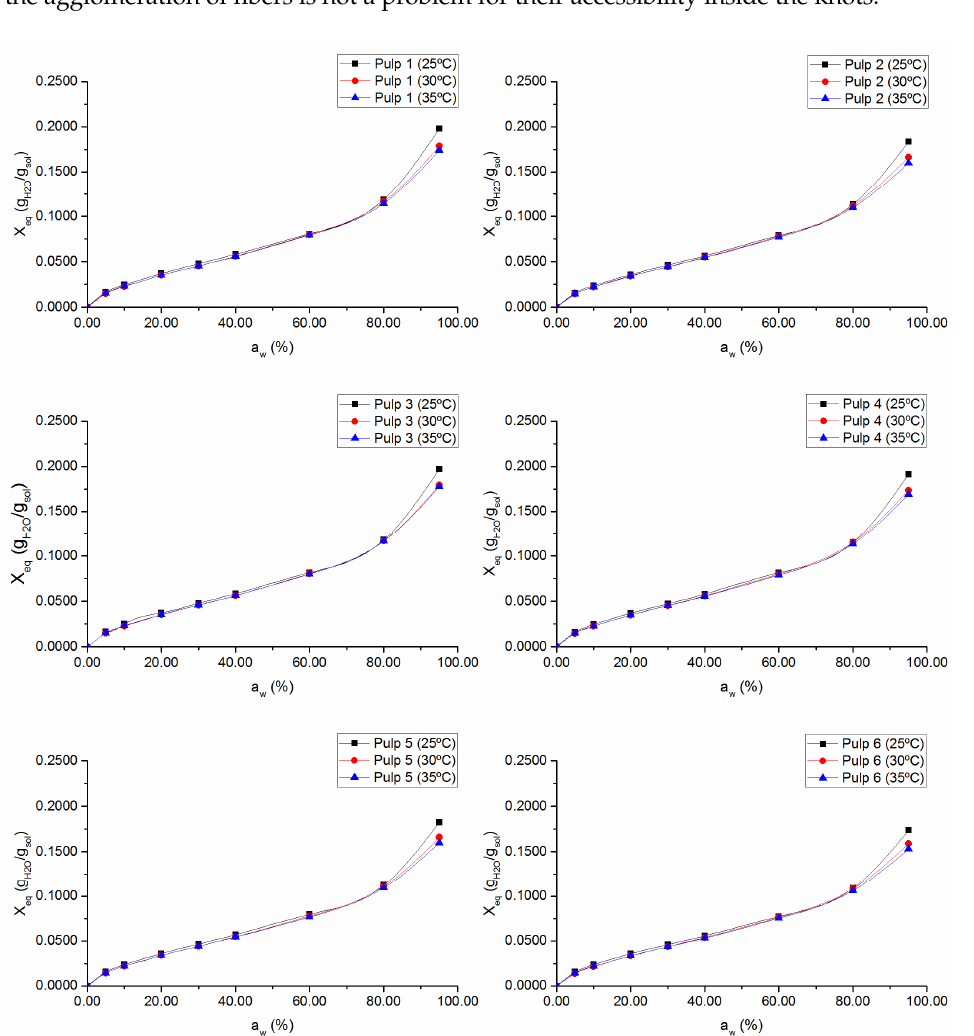
Figure 1. Sorption isotherms of pulps 1 – 6 without knots at 25, 30, and 35 ◦